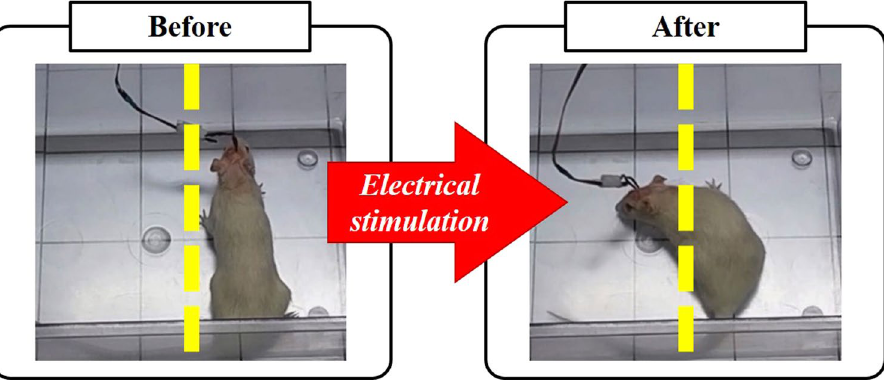
Figure 3. Change in the position of the ratbot in response to electrical stimulation of the right hemispheric NS pathway. The yellow dashed line is a reference for measuring the degree of turning and the amount of forward movement. With these images, we can see that electrical NS pathway stimulation can induce contralateral turning